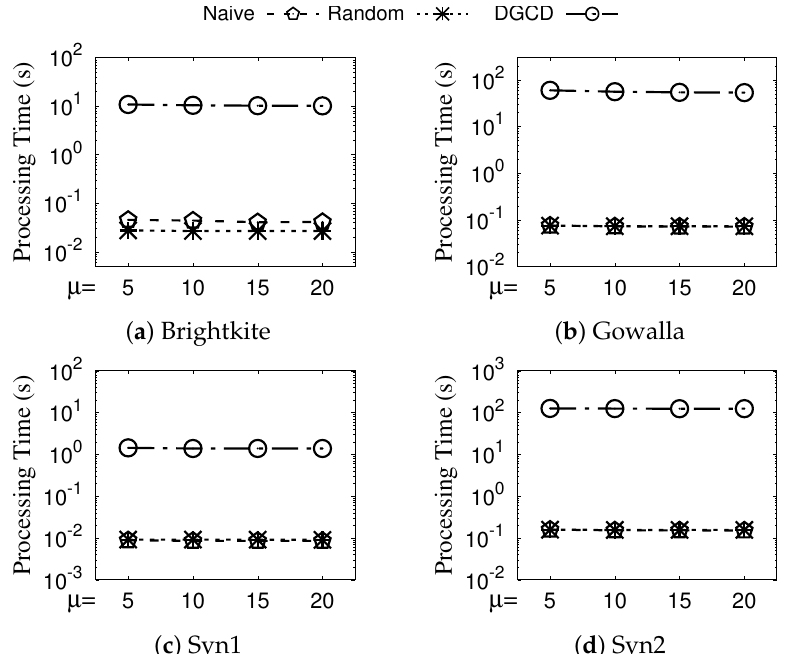
Figure 8. (Eval-IV) Against existing algorithms (vary µ ).